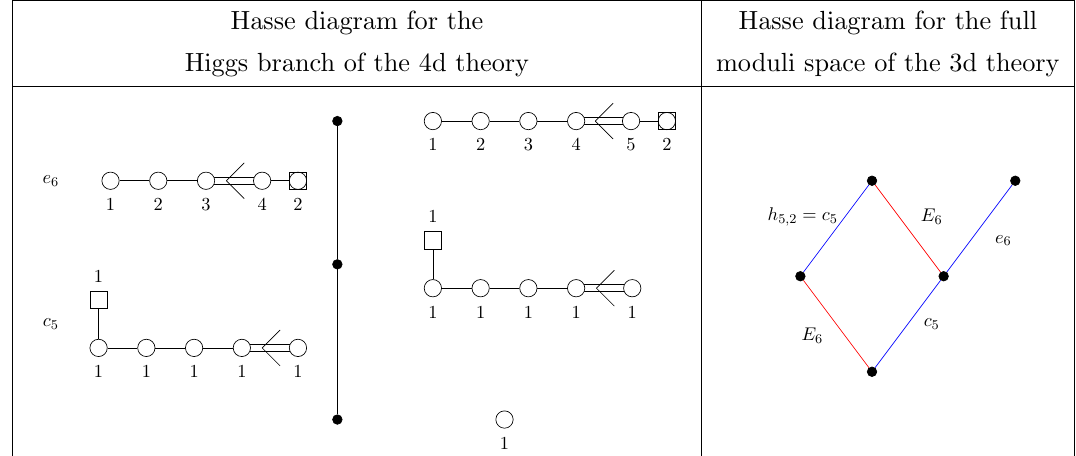
Table 4 . C 5 theory. Left : Hasse diagram for the Higgs branch of the 4 d the right of the Hasse diagram are the magnetic quivers for the closures of the leaves and to the left are magnetic quivers for the slices. This Hasse diagram is already explored in [44, 47]. Right : Hasse diagram for the full moduli space of the theory in 3 d